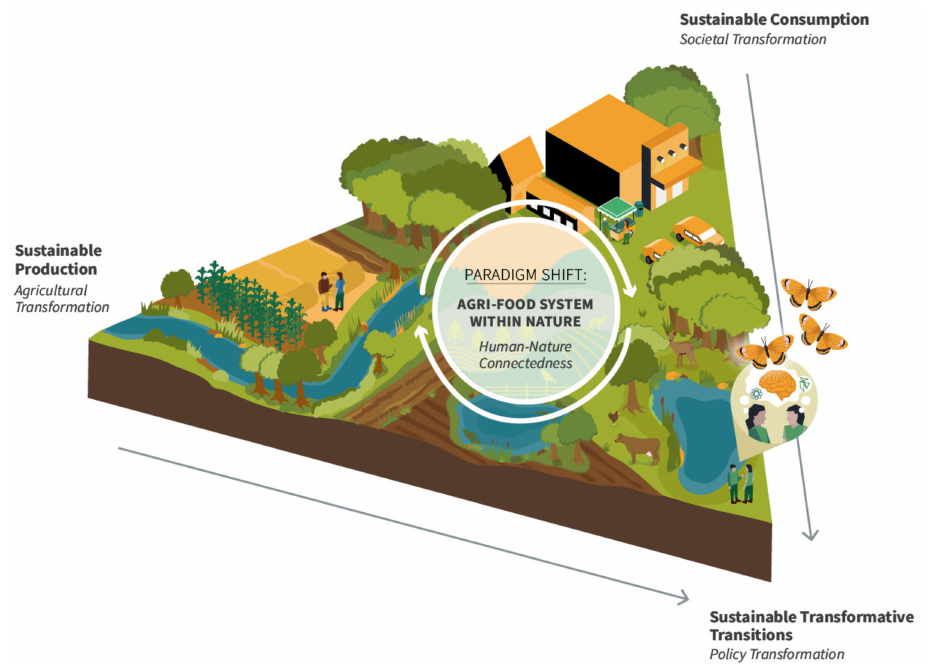
Figure 1. A shift in the paradigm is needed to reconnect people with nature. The new paradigm uses sustainable production and consumption as the starting points to develop a transformative transition to an agri-food system within nature. To achieve that, a policy transformation based on inclusive and integrative governance approaches is needed, enabling conditions for fostering human-nature connectedness, and eventually, for developing sustainable